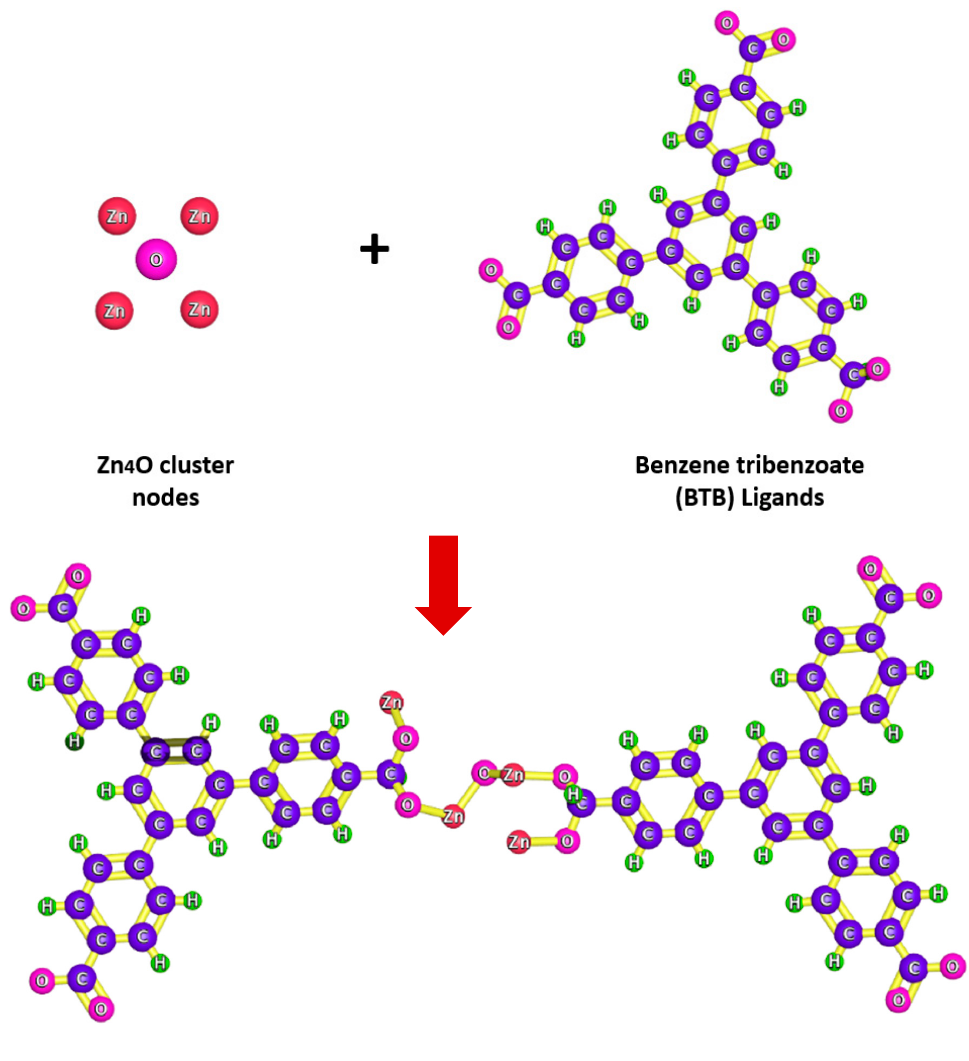
Figure 1. Typical synthesis approach for metal-organic framework MOF-177.